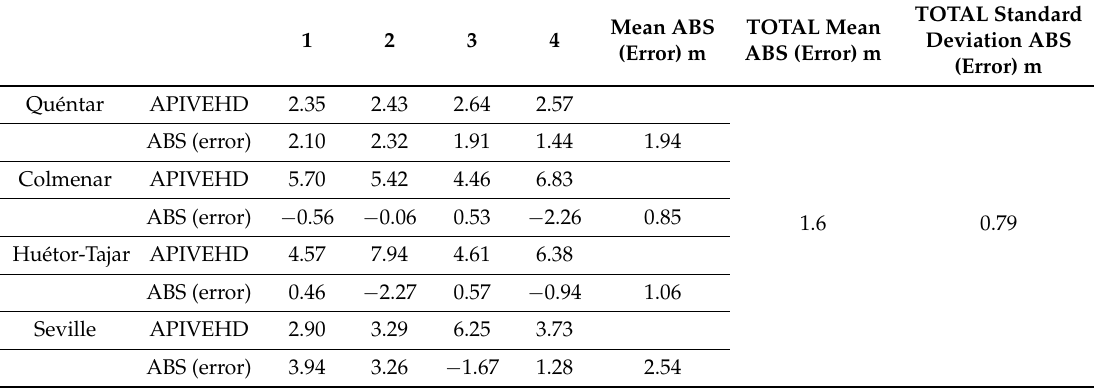
Table 7. PIVED after applying the scale factor (APIVED). High interrogation window.